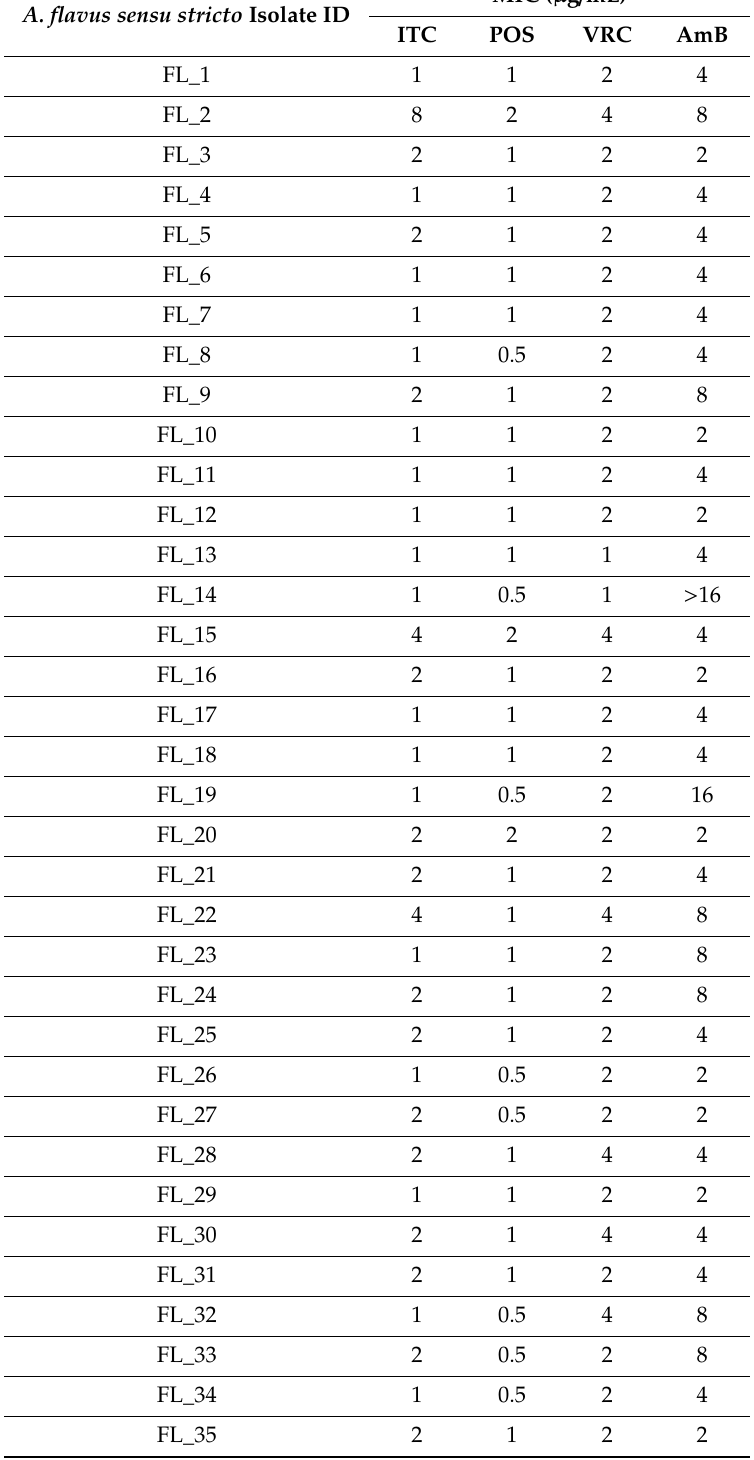
Table 4. Anti-fungal MIC values of A. flavus sensu stricto isolates from the Mekong Delta Region of Vietnam ( n =